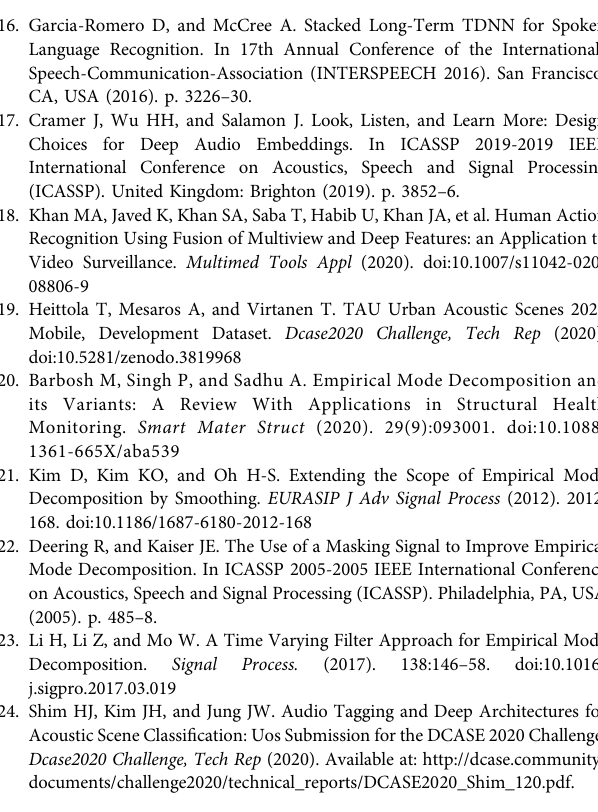
Algorithm Based on Deep Learning. Appl Mathematics Comput (2021). 401: 126012.